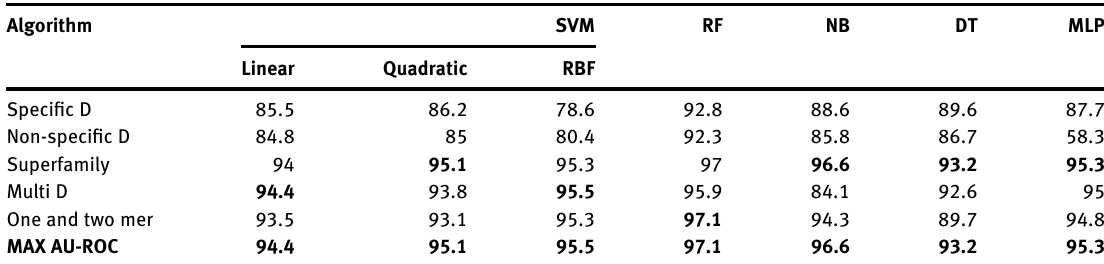
Table  : The algorithms performance evaluation based on AU-ROC with different features set (bold numbers indicates the best performance in each